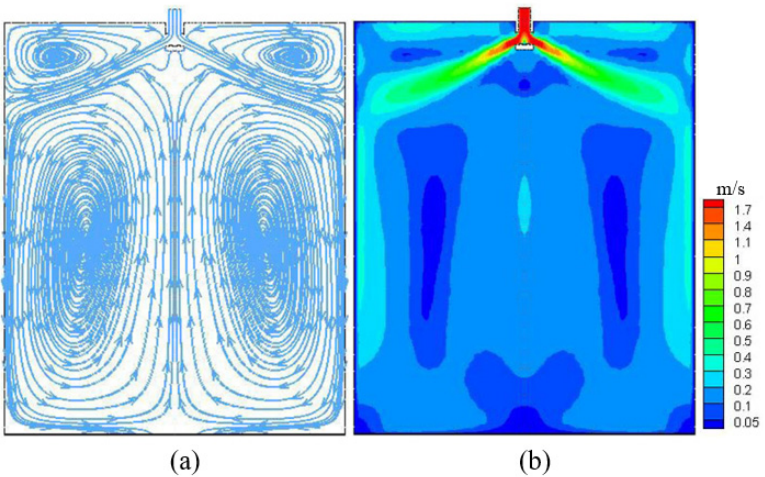
Figure 9. Fluid contours: ( a ) trajectory line; and ( b ) flow field at a thickness of 260 mm.